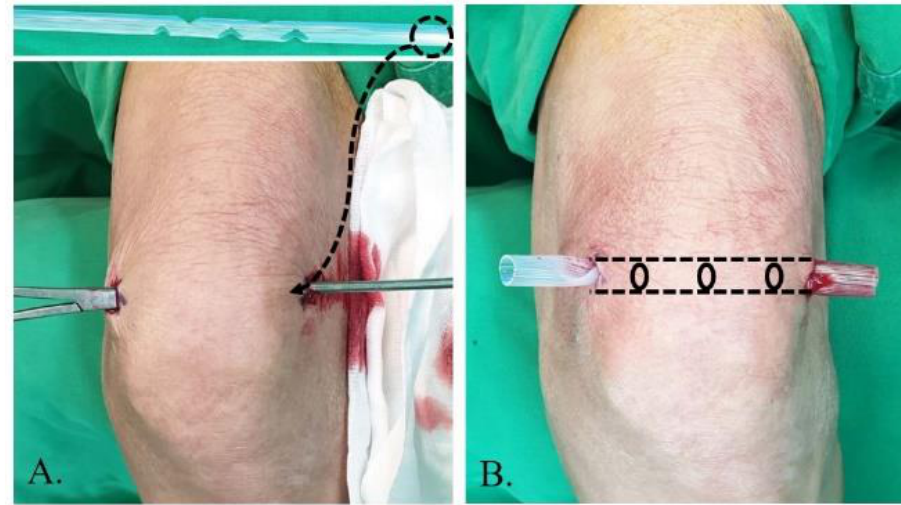
Figure 2. Tube insertion strategy from the superolateral to superomedial portal performed under local anesthesia. ( A ) The tube is inserted using Kelly forceps and switching stick. ( B ) The tube is positioned by tagging.